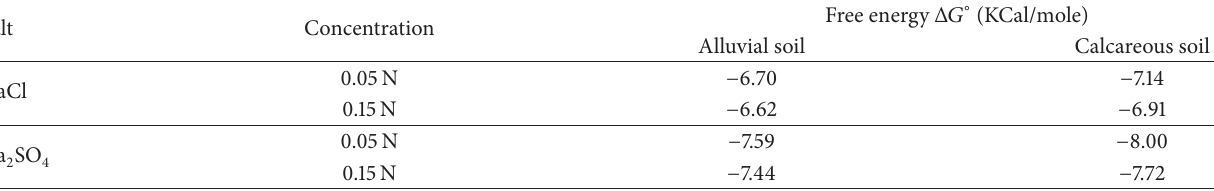
Table 3: Free energy of cadmium adsorption for the two examined soils under different conditions of salt matrix and concentration. Salt Concentration